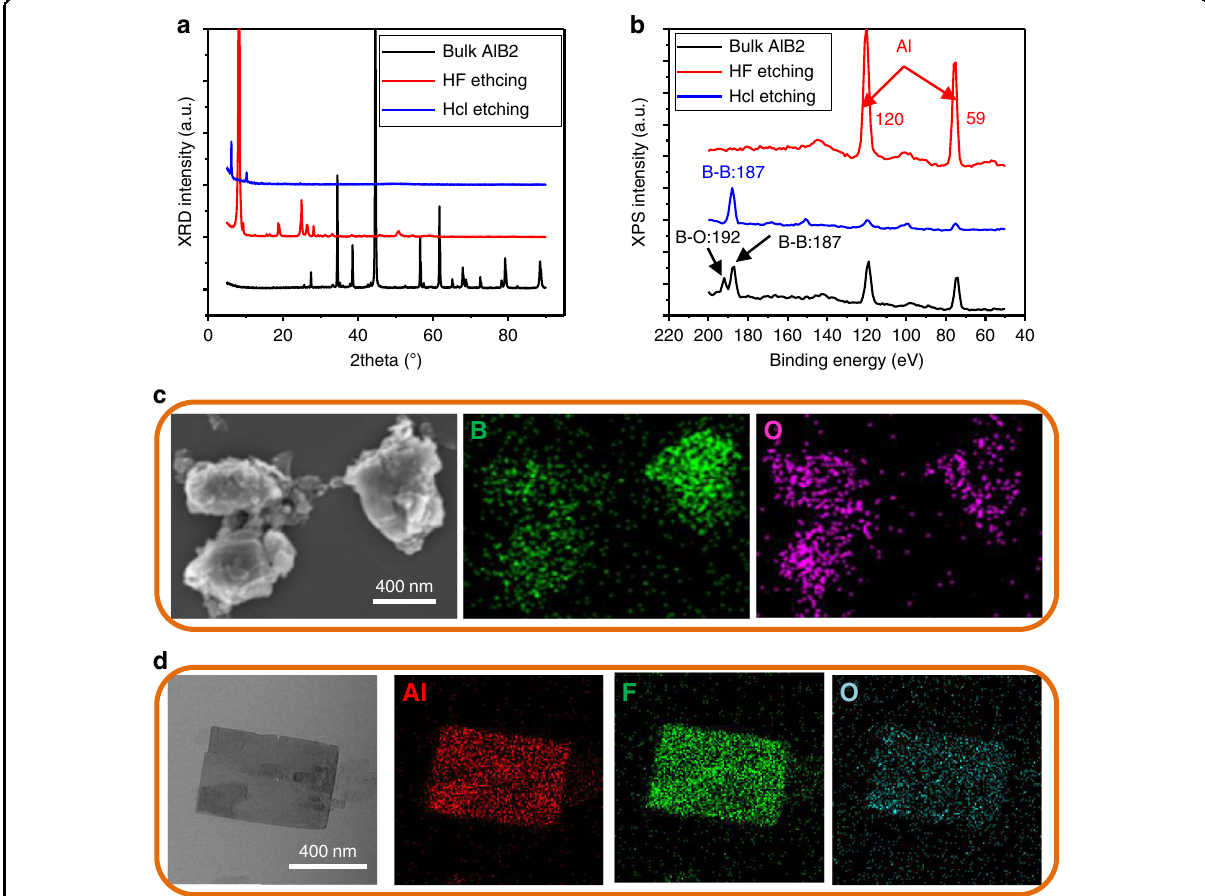
Fig. 2 Chemical etching techniques for borophene. a , b XRD and XPS patterns of bulk AlB 2 , boron product after HCl etching and aluminum product after HF etching. c , d EDS mapping after HCl and HF etching,